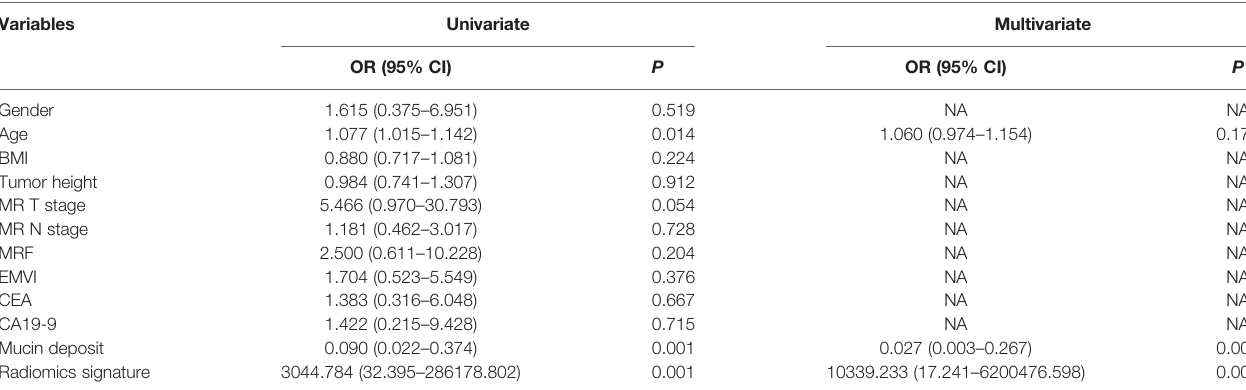
TABLE 3 | Logistic regression analyses of predicting tumor regression grade.